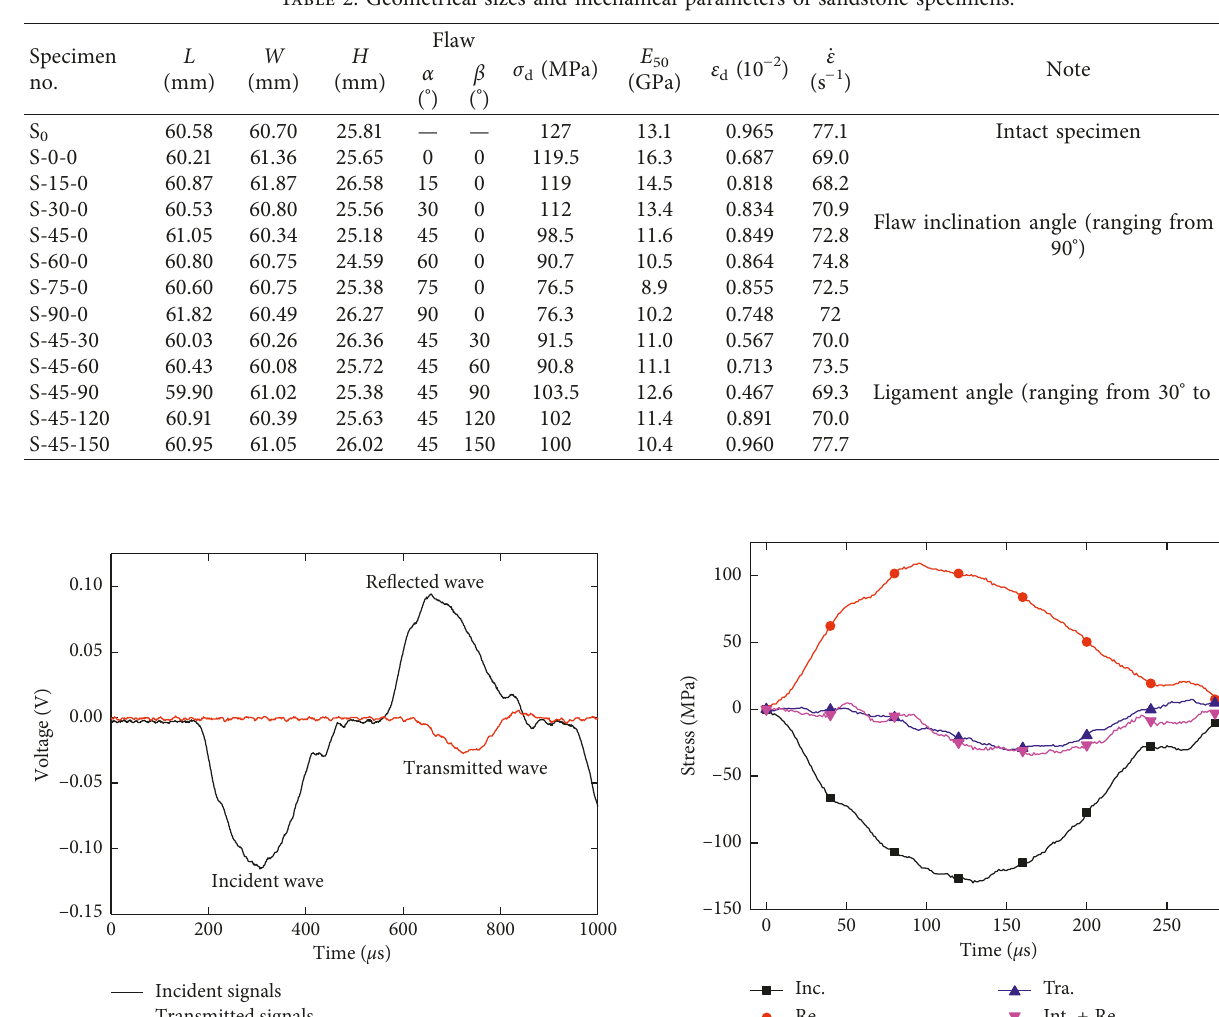
Figure 2: Geometry of the double-flawed sandstone specimen named Table 2: Geometrical sizes and mechanical parameters of sandstone specimens.